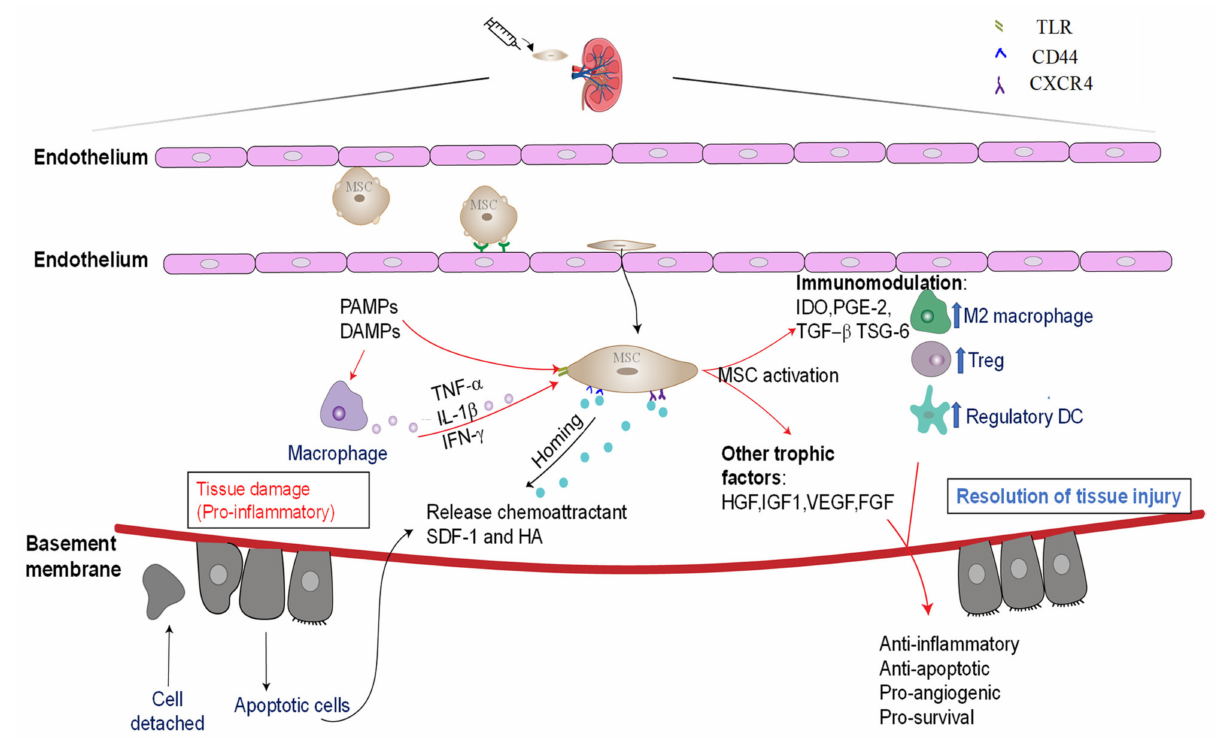
Figure 3. Renoprotective effects of BM-MSCs mediated via immunomodulation and secretion of tropic factors. Following infiltration into the injured tissue, BM-MSCs interact with various adhesion molecules lining the endothelium to ensure their localization to the damaged site. The site of primary insult releases chemoattractant SDF-1 and HA, which bind to CXCR4 and CD44, respectively, on the surfaces of BM-MSCs to enhance their homing. The local microenvironment contains numerous pro-inflammatory factors released by the damage area (such as IL-1 β and TNF- α ), which along with toll-like receptor activation, is critical for the priming and activation of BM-MSCs. Once activated, BM-MSCs release a wide range of trophic factors and mediate immunomodulatory effect to resolve tissue inflammation and promote structural and functional